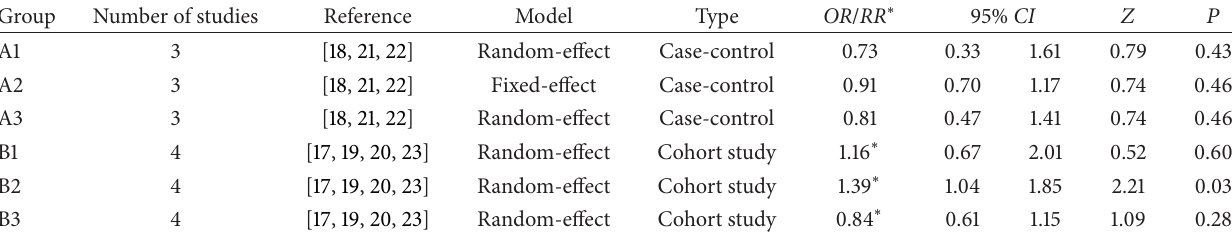
Table 2: Meta-analysis for all groups.